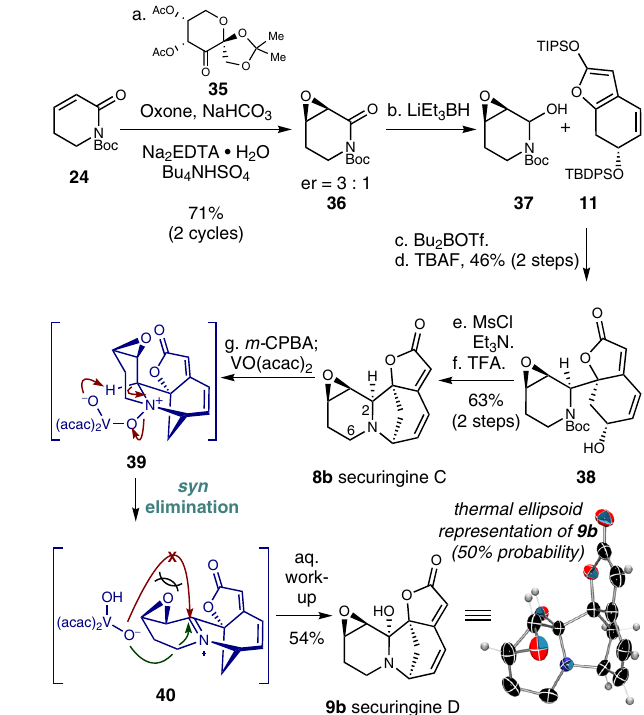
Fig. 5 | Total synthesis of securingines C (8b) and D (9b). Reagents and condi- tions: (a) Oxone (10.0 equiv), NaHCO 3 (30.0 equiv), 35 (0.5 equiv), Na 2